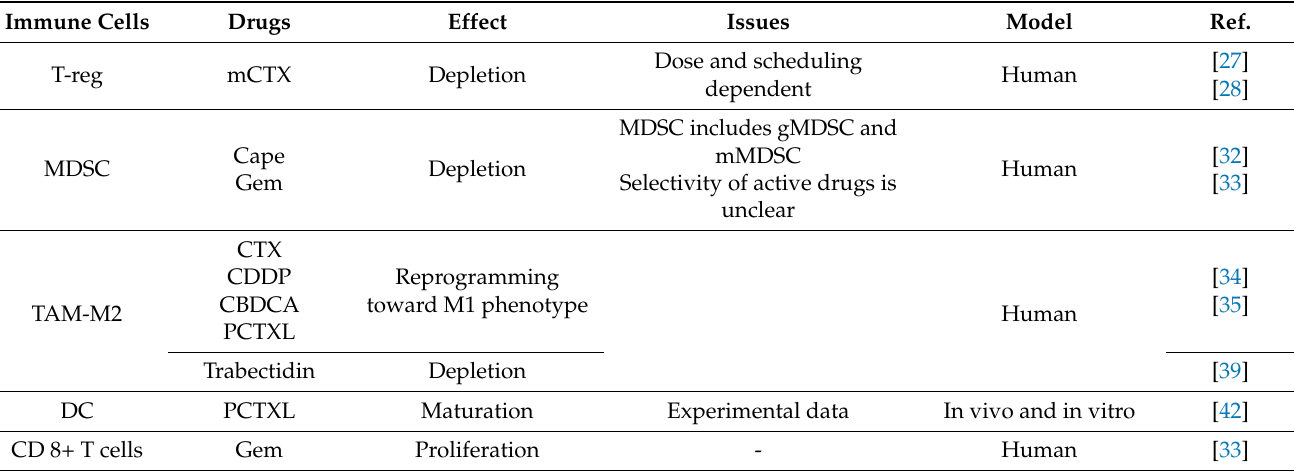
Table 2. Effects of selected chemotherapy drugs on immune